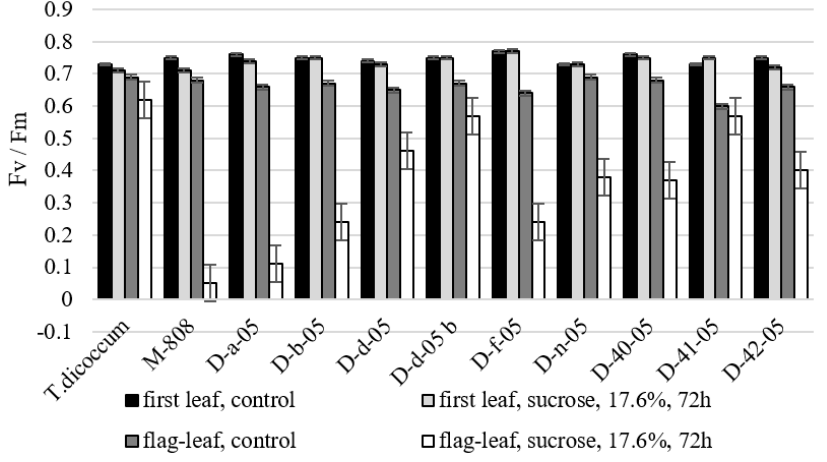
Figure 5. Changes of the maximum photochemical efficiency of PSII (Fv/Fm) of alloplasmic lines under drought conditions (17.6% sucrose, 72 h). Values presented are means (± SD).